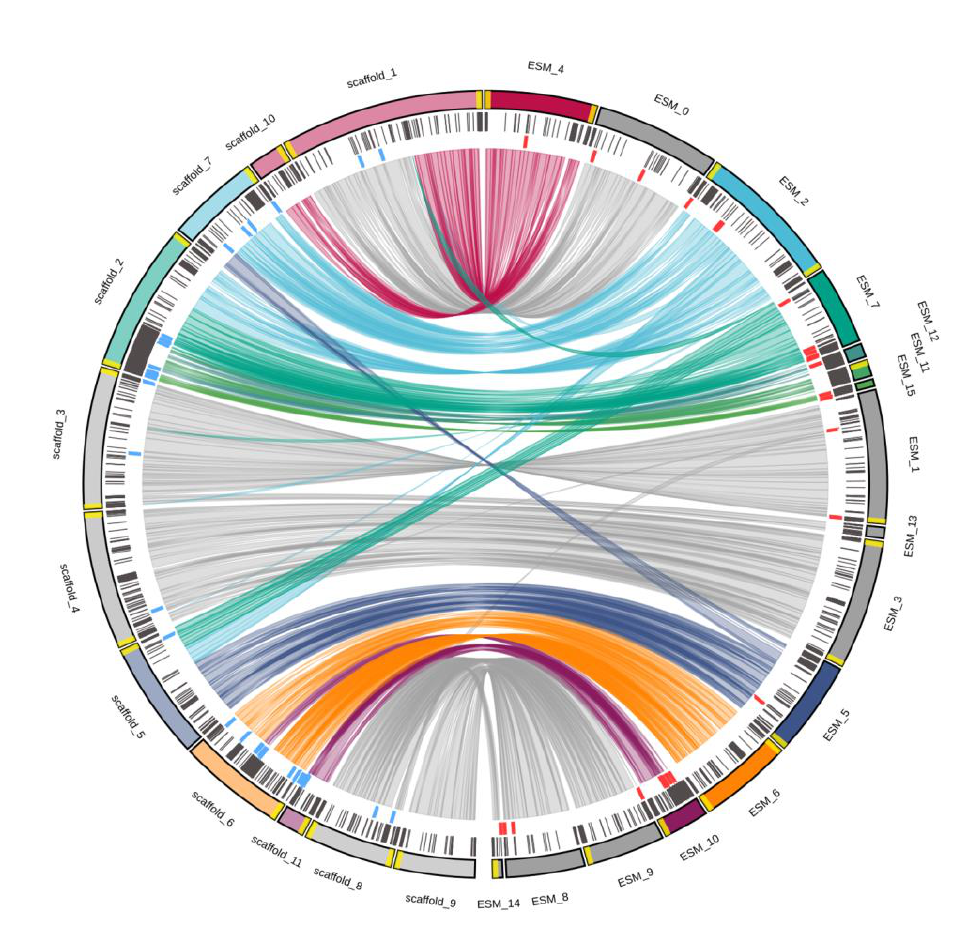
Figure 4. Syntenic relationships and genomic rearrangements between the two Cryphonectria parasitica genomes of the isolates EP155 and ESM015. Circular representation of the syntenic relationships between the two genomes. Links are the syntenic regions higher than 10kb and with a similarity higher than (95%). Coloured scaffolds are scaffolds presenting chromosomal rearrangements between the two genomes. Yellow marks at the extremities of scaffolds are the identified telomeric motifs. Black marks of the second circle represents the density of TEs. Blue and red marks represent the location of the Crypt1 copies for EP155 and ESM015 genomes